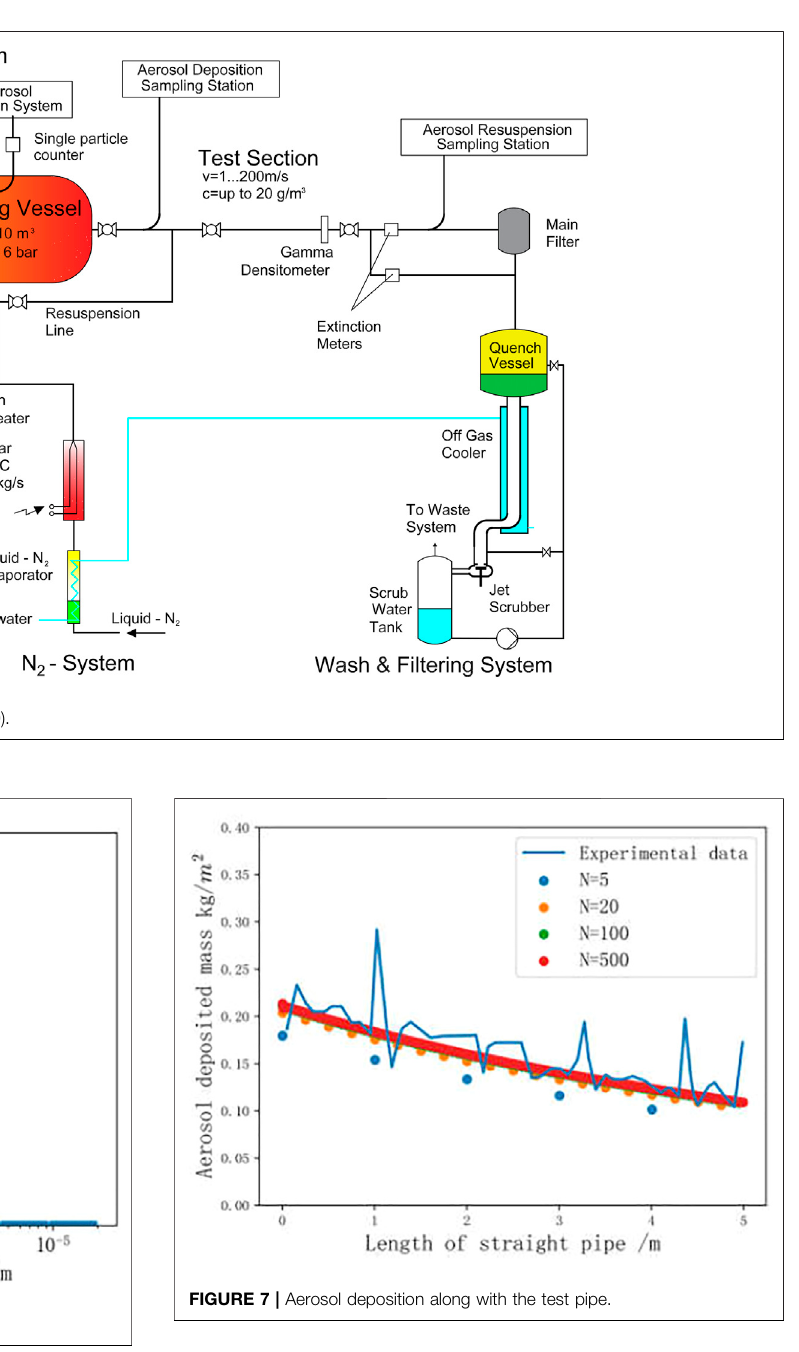
FIGURE 6 | Initial aerosol distribution.